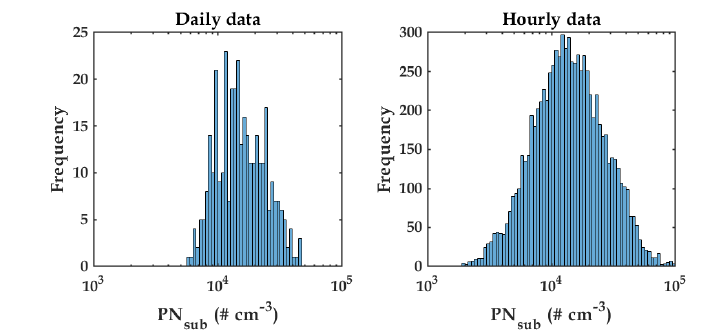
Figure 2. PN number concentration histograms during the experiments for daily averaged data ( left ) and hourly averaged data ( right